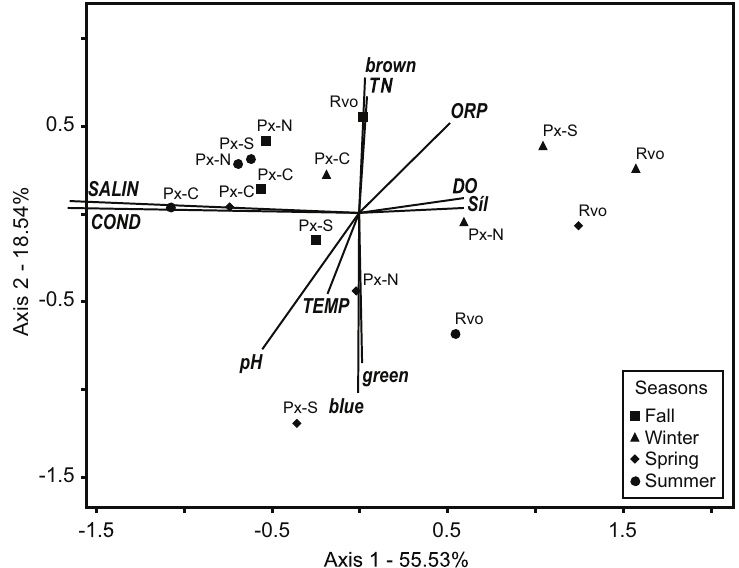
Figure 3 - Principal Component Analysis (PCA). Ordination diagram of the physical and chemical variables of different seasons in the Ruivo and Peixe lagoon. (Legend for locations and variables see Table